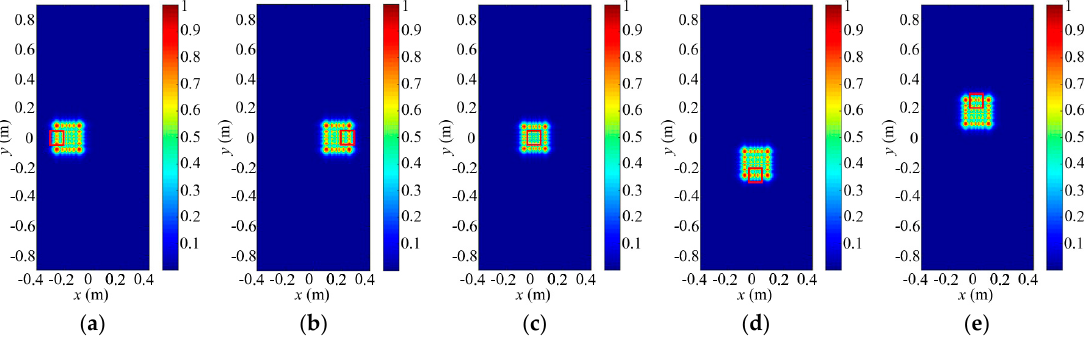
Figure 8. Distributions of incident fields on the left face of the imaging area for different 3D imaging cells with different PPMFs ( f focal @( x 0 , y 0 )): ( a ) 0.2069@( − 0.0603, 0); ( b ) 0.2069@(0.0603, 0); ( c ) 0.2046@(0, 0); ( d ) 0.2069@(0, − 0.0603); and ( e ) 0.2069@(0, 0.0603).